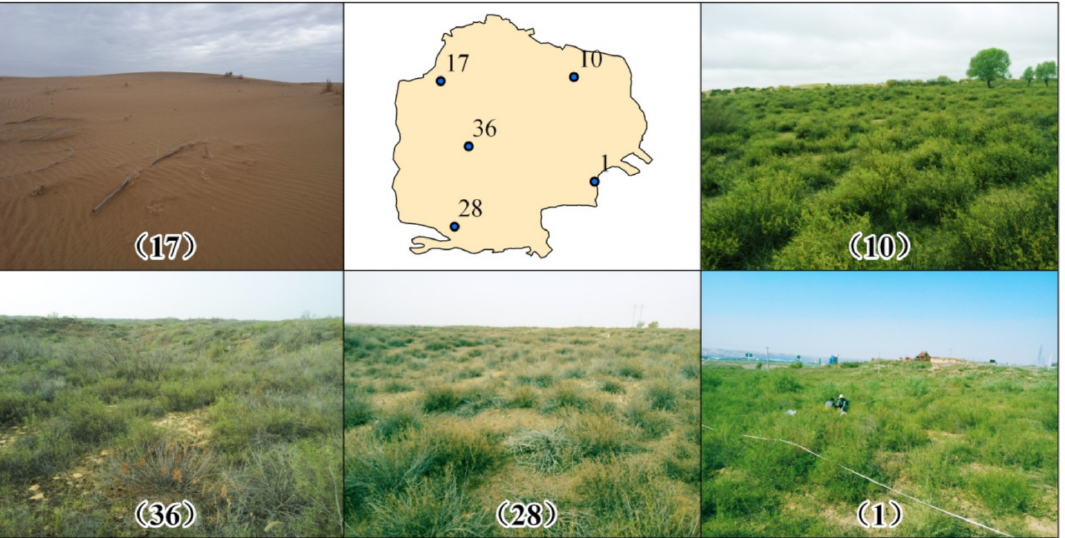
Figure 10. Photographs of typical sampling points in the Mu Us Sandy Land. (The numbers 1,10,17,28,36 mean part of sample points numbers same as Figure 1. The numbers (1), (10), (17), (28), (36) is the number of landscape photos of corresponding sample